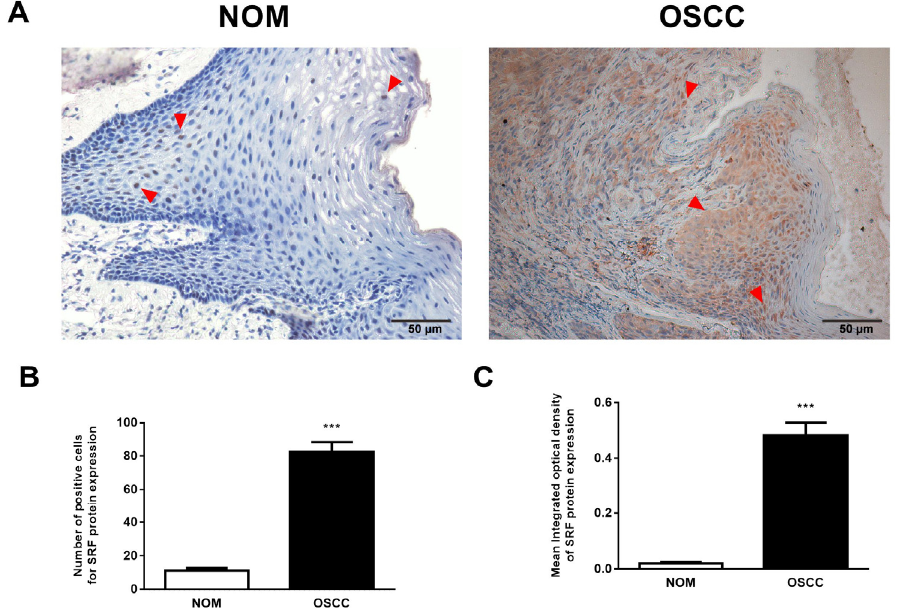
Figure 1. SRF is upregulated in human OSCC tissues. ( A,B ) Representative immunohistochemical images of SRF expression in NOM ( A ) and OSCC ( B ) tissues. representative staining of SRF marked by read triangle. Statistical analysis of proportions of SRF ( C ) positive cells and ( D ) staining intensity in OSCC and NOM tissues. Scale bar, 50 µ m. *** p < 0.001 (Student t-tests vs. NOM). Scale bar: 50 µ m. NOM, normal oral mucosa; OSCC, oral squamous cell carcinoma; SRF, serum response factor.